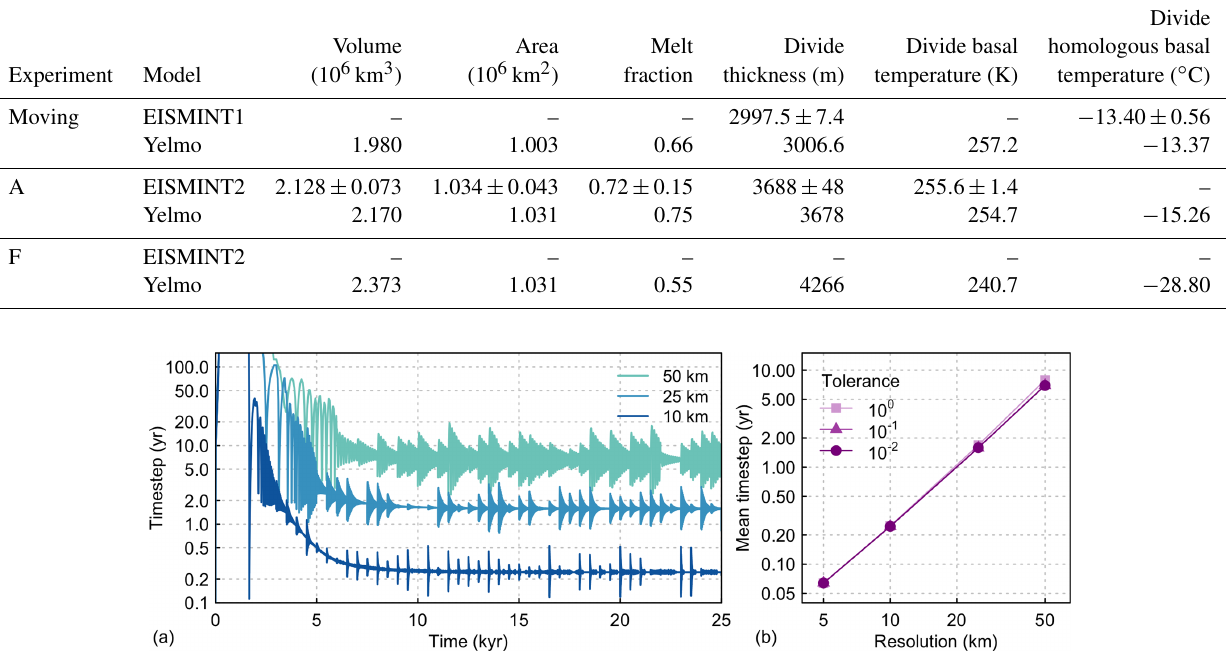
Figure 4. (a) Adaptive timestepping for the EISMINT1 moving margin experiment. Time series of the timestep used by Yelmo for grid resolutions of 50km, 25km and 10km and a tolerance of (cid:15) = 10 − 2 and (b) the mean adaptive timestep in the time range of 15–25kyr versus model resolution. Separate lines in (b) show results for different values of the tolerance parameter (cid:15)